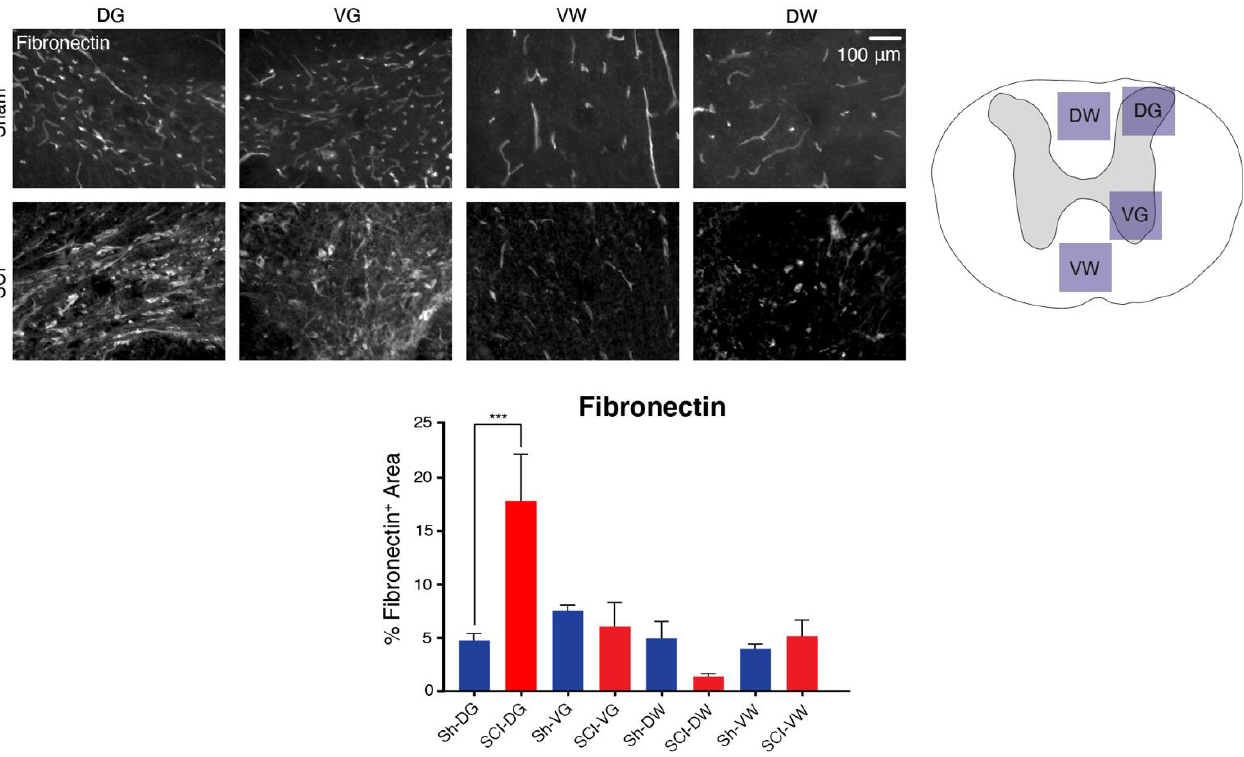
Figure 5. The presence of fibronectin (expressed by Fn1 ) in Wistar rat thoracic spinal cords at 3 dpi compared to time- matched laminectomized shams ( n = 5 per cohort). The images were taken at the dorsal horn grey (DG), ventral horn grey (VG), dorsal horn white (DW), ventral horn white (VW) matter. Data represented as mean +/− SEM and analyzed using two-way ANOVA with Holm-Sidak multiple comparison test. *** indicates p -adj. < 0.001.